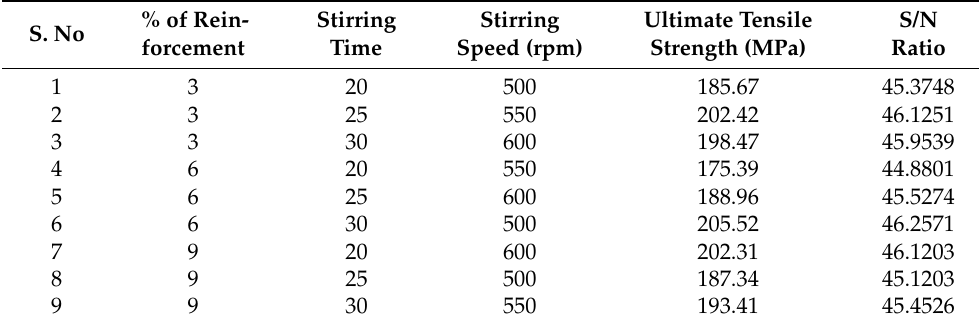
Table 6. Experimental summary of ultimate tensile